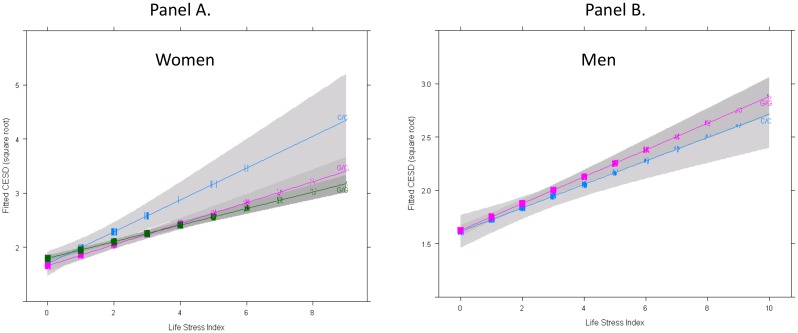
Interaction between the stress index and rs6318 genotypes predicting depressive symptom scores among White women (Panel A) and White men (Panel B).Estimates are adjusted for antidepressant use and age. Shaded gray areas represent 95% confidence bands generated using the Huber-White estimator. Tick marks represent case density. The sample was comprised of 86 C/C, 738 G/C, and 1,888 G/G women, and 360 C/- and 2,006 G/- men. The interaction term was statistically significant for women (p = .022), but not for men (p = .471).